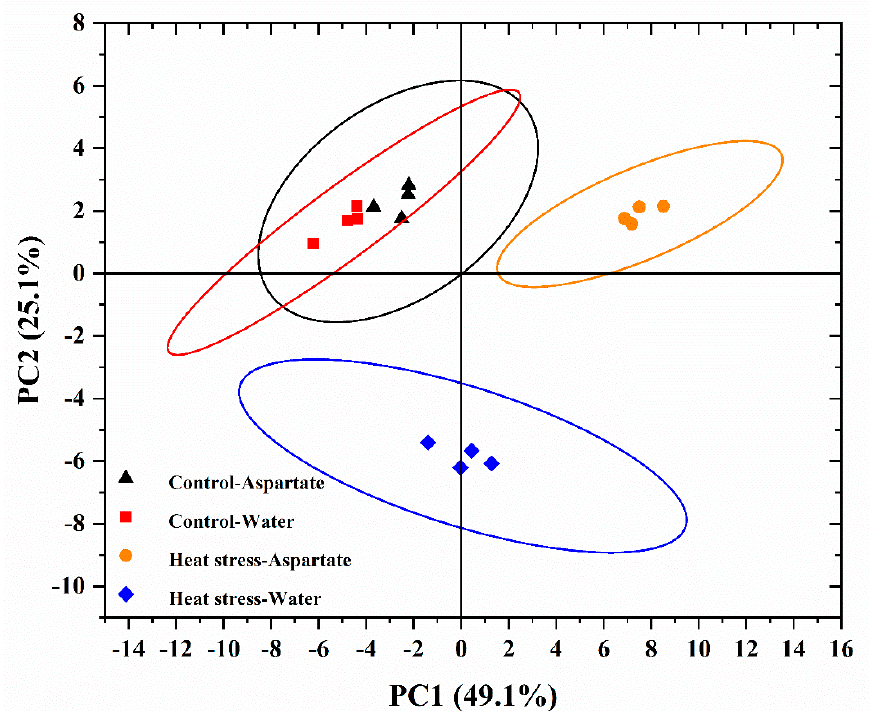
Figure 3. Principal component analysis (PCA) of differentially regulated metabolites by water and aspartate (Asp, 2 mM) treatments of perennial ryegrass exposed to control temperature and heat stress conditions. stress